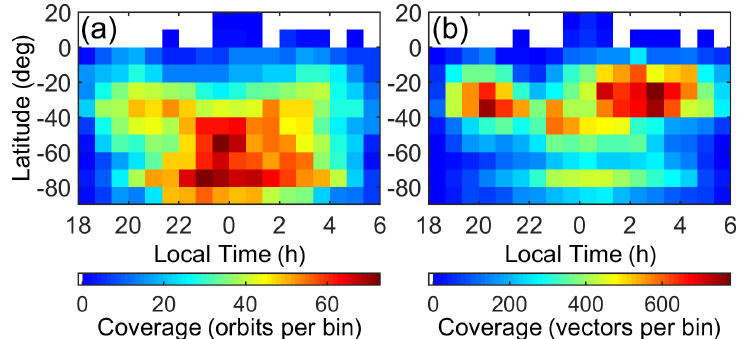
Figure 1. Coverage of Venus nightside by velocity vectors retrieved in this work. This distribution uses 40 min LT × 10 ◦ latitude bins. ( a ): number of orbits (per bin) that were eligible for velocity retrieval. ( b ): number of vectors (per bin) retrieved in total.